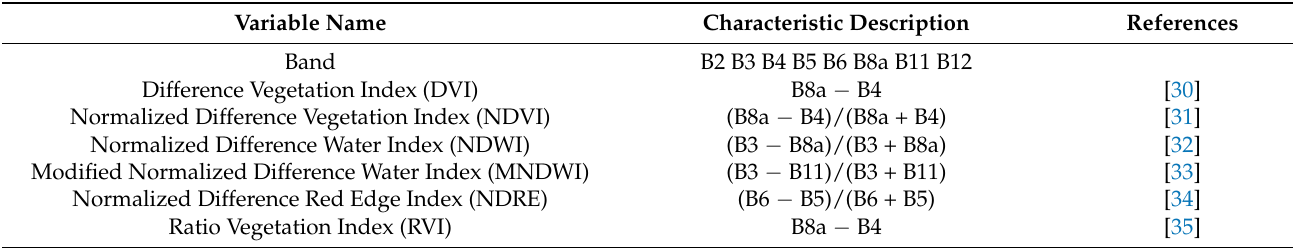
Table 1. Sentinel-2 characteristic variables and description.